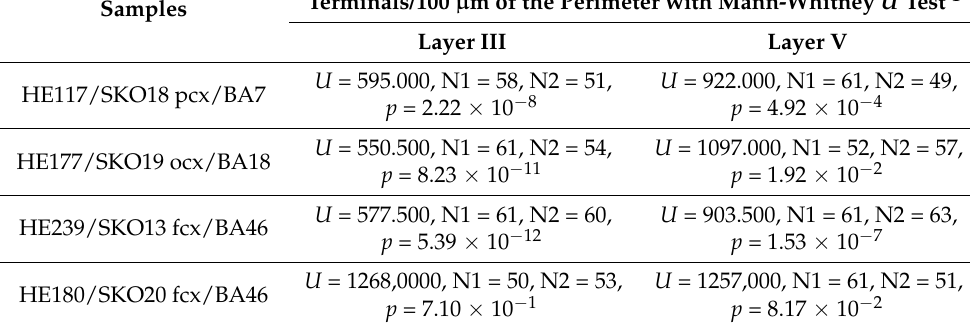
Table 4. Comparisons of the number of PV-immunopositive terminals/100 µ m of soma perimeter with Mann-Whitney U test in cases with mostly normal-sized